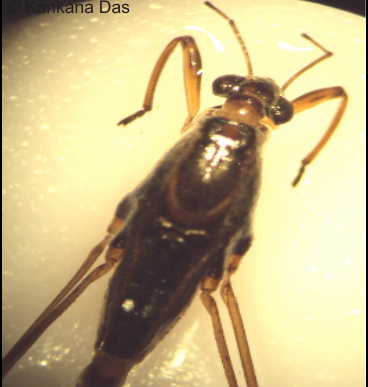
Image 12. Diplonychus annulatus